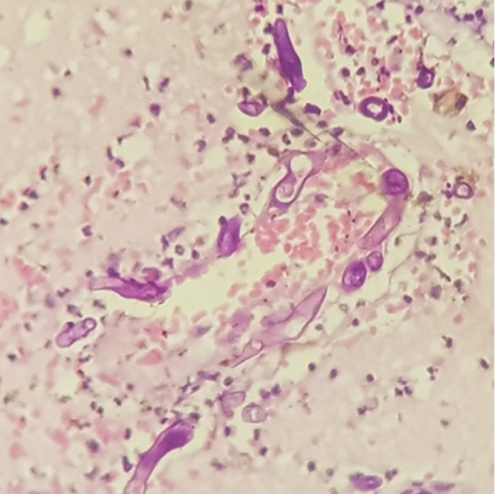
Figure 5a - Photomicrograph of the brain with mucormycosis lesions: bacilliform tube-shaped hyphae with septa and spherulas. A, Grey matter of the cerebral cortex with infiltration of mucormycosis hyphae and softening of the substrate around the vessel.